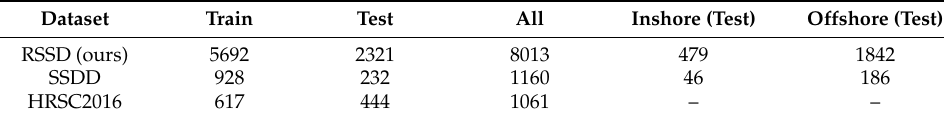
Figure 17. Statistical comparison between the proposed RSSD and the SSDD. Here, ( a ) and ( e ) show the width and height distribution of ship ground truths in RSSD and SSDD, respectively; ( b ) and ( f ) display the aspect ratio distribution of ship OBBs; ( c ) and ( g ) indicate the area distribution of ship OBBs; ( d ) and ( h ) show the rotation angle distribution of ship OBBs. Table 3. Details of dataset